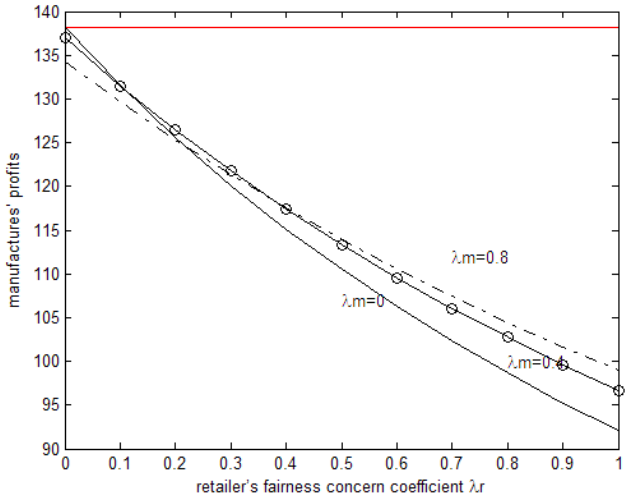
Figure 2. The effects of the fairness concern coefficient on the manufacturer’s profits.